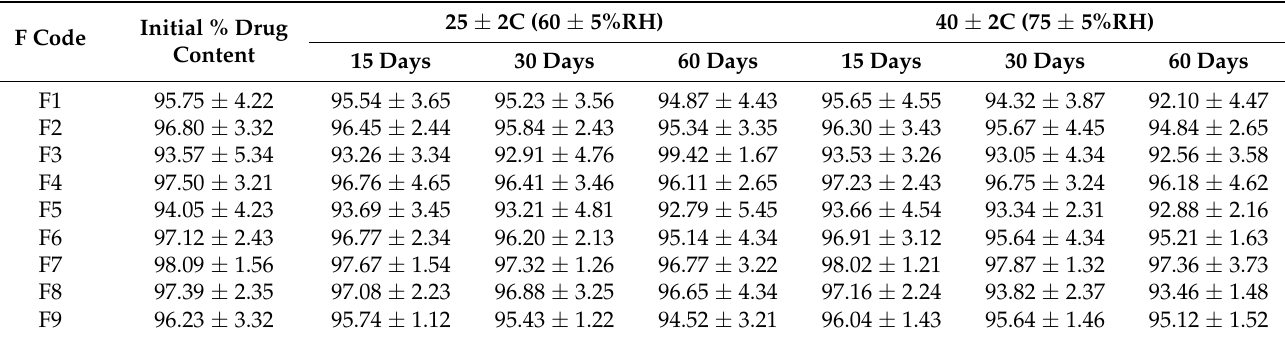
Table 3. Stability study of transdermal patches (F1–F9) at various temperatures and humidity